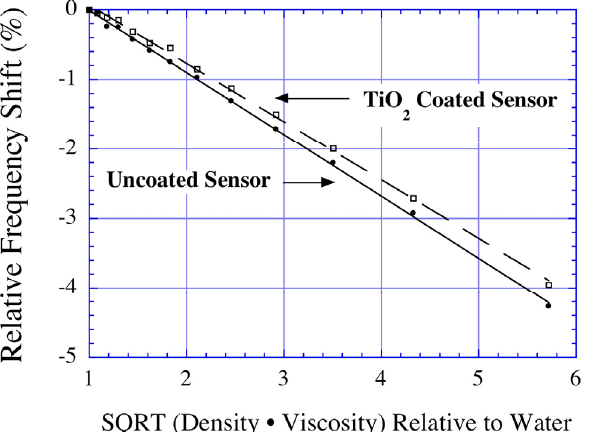
Figure 18. Relative frequency shifts of a bare (uncoated) and a TiO the simultaneous measurement of viscosity and liquid density. Reprinted with permission from